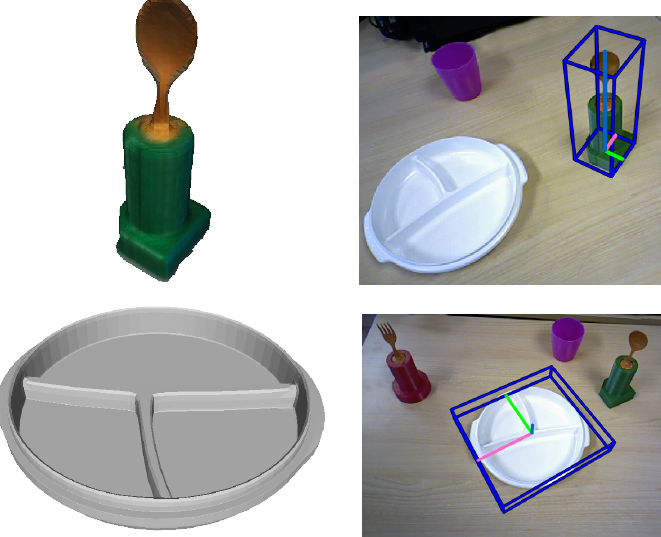
Figure 8. Qualitative results visualisation of the estimated pose of two project objects. The spoon model was scanned and the plate was modelled.